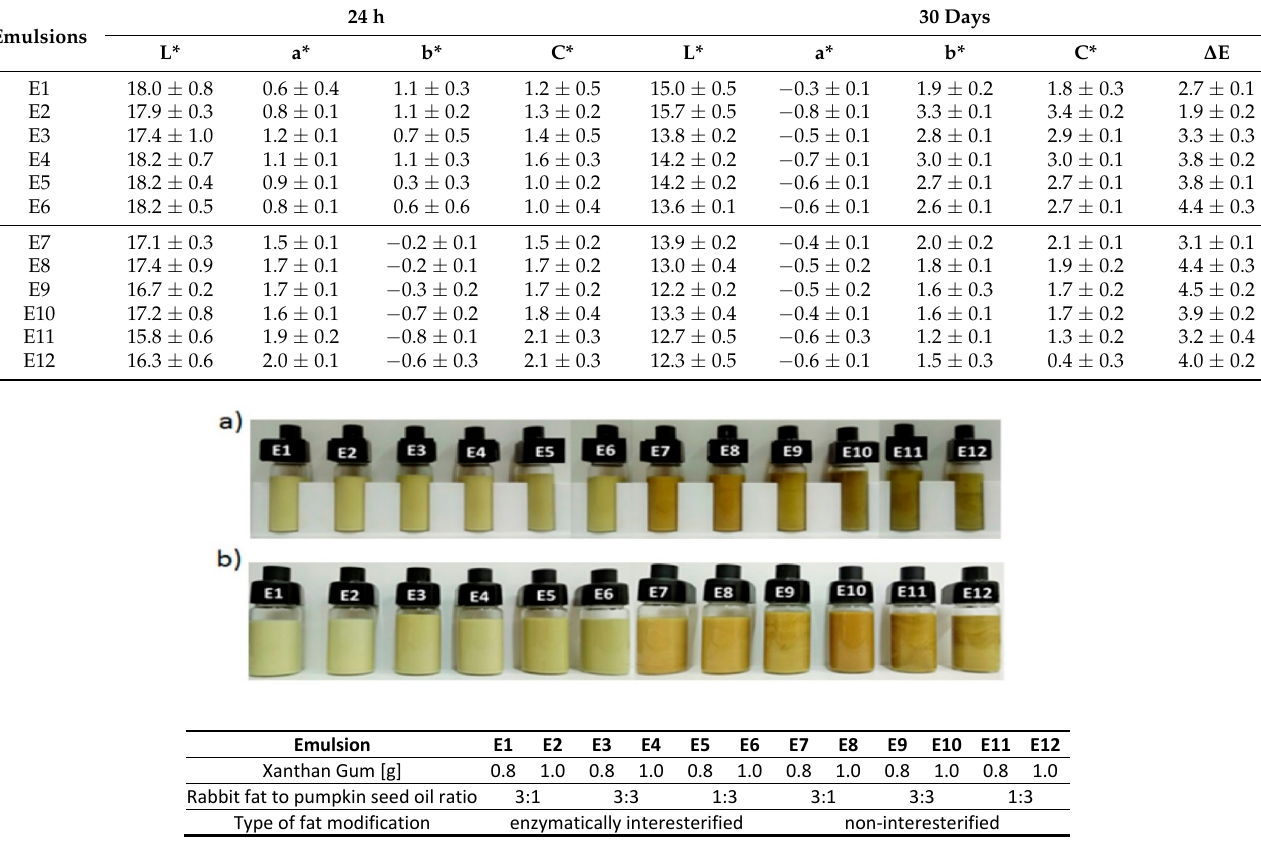
Figure 3. The appearance of emulsions E1-E12 ( A ) after 24 hours and ( B ) 30 days from their prepa- ration.